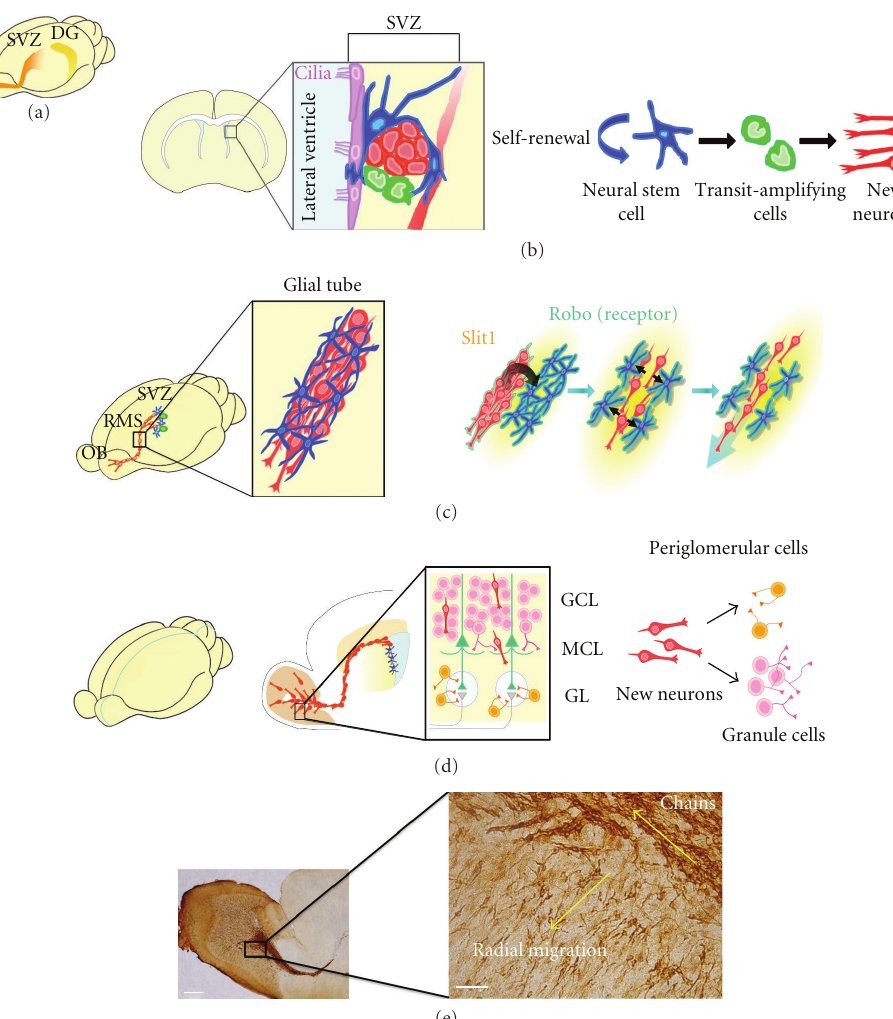
Figure 1: Neurogenesis in the adult brain. (a) Schematic drawing of adult rodent brain showing the two regions, the SVZ and the DG, where new neurons are continuously generated. (b) Location and structure of the SVZ. The SVZ consists of four types of cells, ependymal cells (purple), neural stem cells (blue), transit-amplifying cells (green), and new neurons (red). Neural stem cells directly contact the ventricle with their apical membrane and extend long basal processes that end on blood vessels within the ventricular wall. The neural stem cell proliferates slowly to replicate itself (self-renewal) and to generate transit-amplifying cells. Transit-amplifying cells proliferate quickly, and the progeny di ff erentiate into immature new neurons. (c) Migration of new neurons. New neurons generated in the SVZ migrate into the OB through the RMS, where they form elongated chain-like cell aggregates, which are surrounded by astrocytic tunnels, called glial tubes. The new neurons (red) in the RMS secrete Slit1, whose receptor, Robo, is expressed on astrocytes (blue). Through the Slit1-Robo pathway, the new neurons regulate the morphology of the astrocytes, promoting the formation and maintenance of the glial tubes, which are needed for the neurons’ rapid and directional migration. (d) Di ff erentiation of new neurons in the OB. New neurons (red) that reach the OB detach from the chain and migrate radially toward their final destinations, where they di ff erentiate into two types of olfactory interneurons, granule cells (pink) and periglomerular cells (orange) in di ff erent layers, the GCL and GL, respectively. (e) Sagittal section of the RMS and OB immunostained for the new neuron marker, DCX. The right panel shows a higher-magnification image of the boxed area at left. Whereas DCX-positive new neurons migrate tangentially in chains, new neurons that migrate radially do so as individuals. Scale bars: left, 500 μ m; right, 200 μ m. SVZ, subventricular zone; DG, dentate gyrus; OB, olfactory bulb; RMS, rostral migratory stream; GCL, granule cell layer; MCL, mitral cell layer; GL, glomerular layer; DCX,